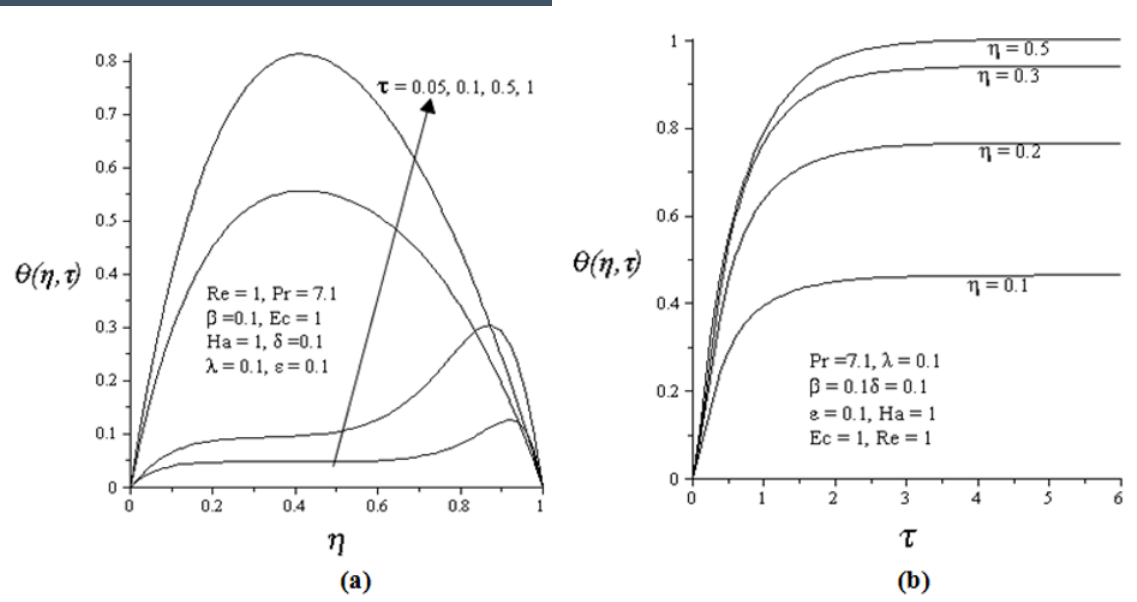
Figure 4. Fluid temperature profiles across the channel with increasing time